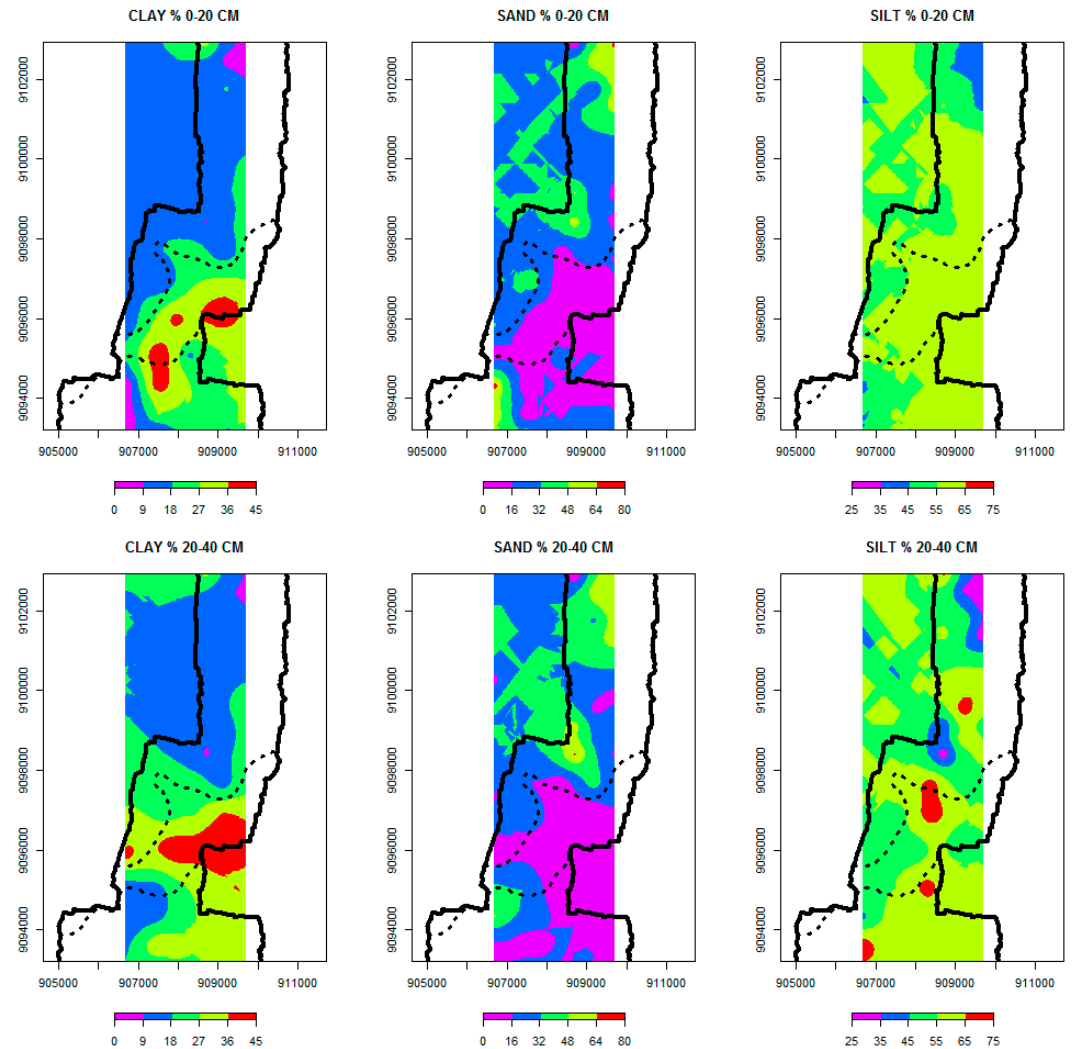
Figure 3. Spatial variation in soil texture (clay, sand, and silt fraction) along hydrological zones of transect derived from the geostatistical kriging method.